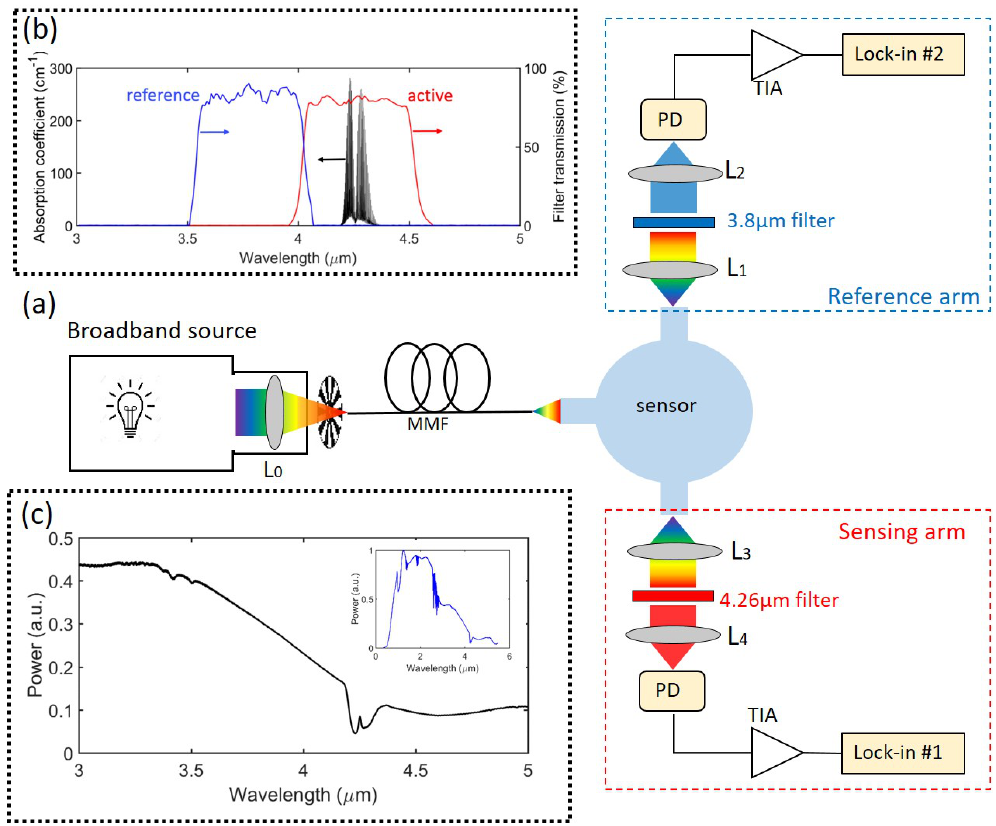
Figure 6. ( a ) Experimental setup. L: lens MMF: multimode fiber, PD: photodiode, TIA: